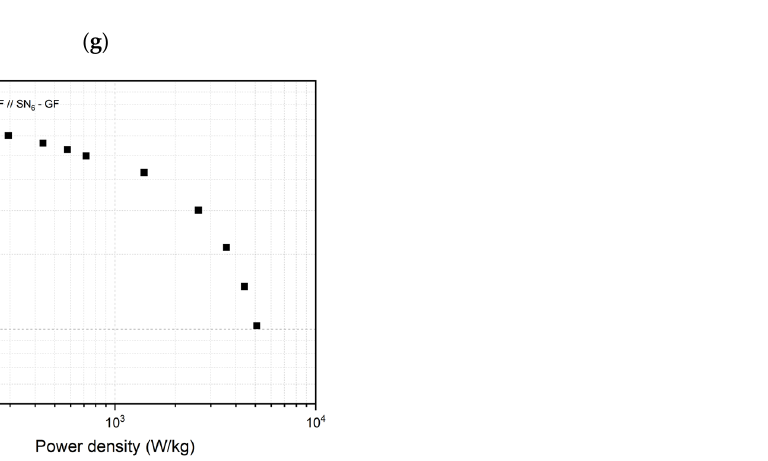
Figure 6. SN 6 − GF (25:75): ( a ) cyclic voltammetry at scan rates ranging from 10 mV · s − 1 to 400 mV · s − 1 . Potential window from − 0.10 V to 1.0 V vs. SCE (1 M Na 2 SO 4 ) electrolytes; ( b ) galvanostatic charge − discharge at applied specific currents from 0.4 to 10 A · g − 1 in 1 M Na 2 SO 4 electrolytes. Electrochemical performance of the SN 6 − GF//SN 6 − GF symmetric cell in 1 M Na 2 SO 4 electrolyte: ( c ) CV curves at scan rates from 10 mV · s − 1 to 400 mV · s − 1 ; ( d ) galvanostatic charge − discharge at applied specific currents of 0.4 to 10 A · g − 1 ; ( e ) specific capacitance at applied specific current from 0.4 A · g − 1 to 10.0 A · g − 1 ; ( f ) capacitance retention after 10,000 cycles of continuous charge − discharge at 10.0 A · g − 1 ; ( g ) Ragone plots of SN 6 − GF//SN 6 − GF symmetric